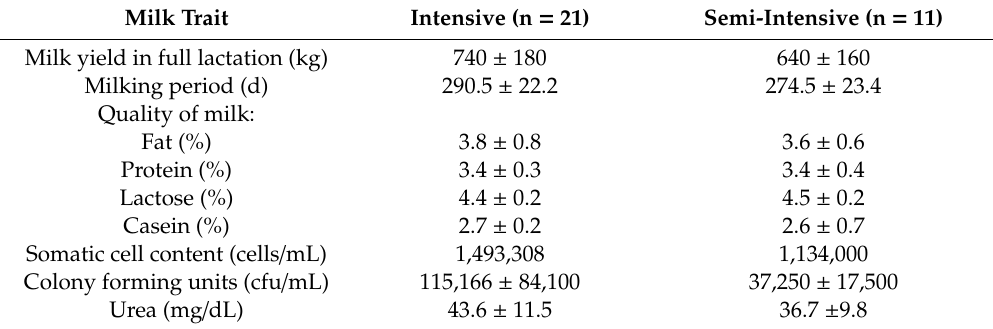
Table 3. Milk yield and milk quality traits (mean ± SD) recorded in intensive and semi-intensive goat farms, Northwestern